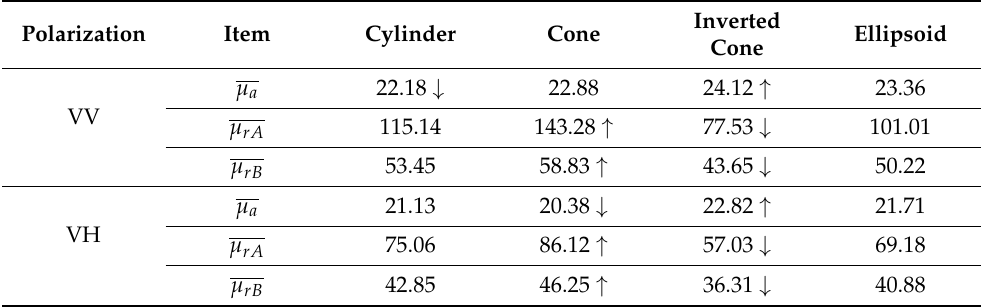
Table 7. µ a and µ r of the MTVM simulation results for the same crown shapes between canopies A and B.